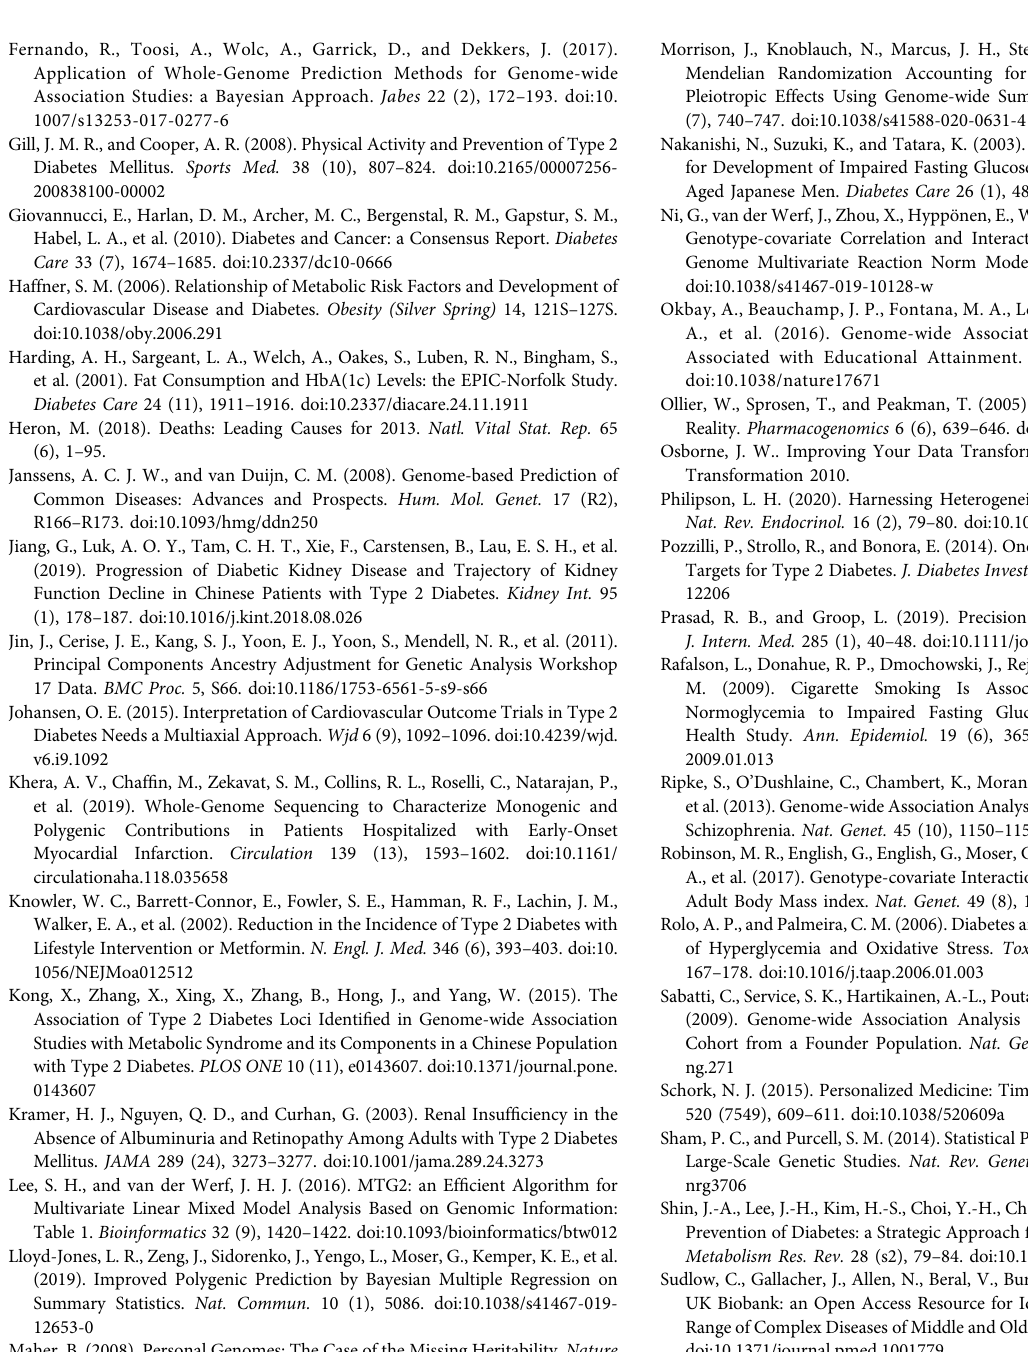
Table 1. Bioinformatics 32 (9), 1420 – 1422. doi:10.1093/bioinformatics/btw012 Lloyd-Jones, L. R., Zeng, J., Sidorenko, J., Yengo, L., Moser, G., Kemper, K. E., et